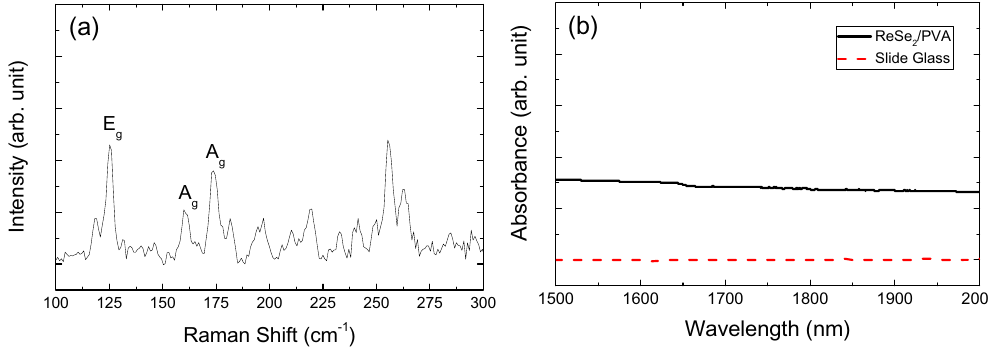
Figure 3. ( a ) A Raman spectrum of the ReSe 2 particles and ( b ) measured linear absorption spectrum of the ReSe 2 /PVA